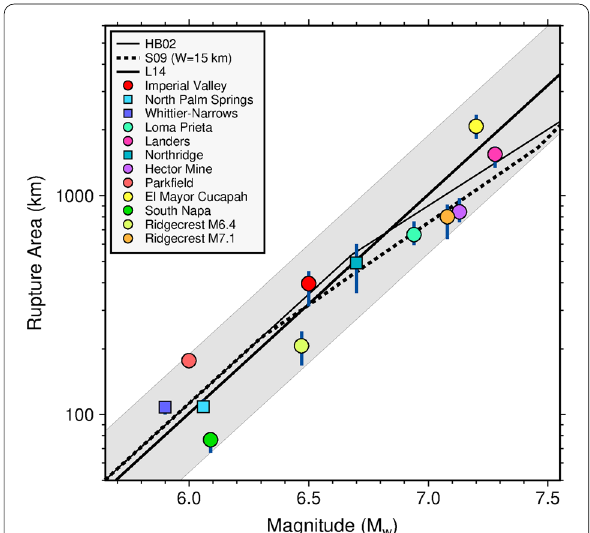
Fig. 12 Comparison of the mean rupture areas for the five lowest misfit realizations for each of the 12 validation events with published relations: HB02 is from Hanks and Bakun (2002), S09 is from Shaw (2009), and L14 is from Leonard (2014). The gray shading indicates the standard deviation estimate from L14. For the simulations, circles denote strike-slip and oblique-slip events, and squares denote reverse-slip events. Symbols are plotted at the mean value and the vertical bars indicate the minimum and maximum rupture areas across the five lowest misfit realizations (bars hidden behind symbol when minimum and/or maximum are very close to